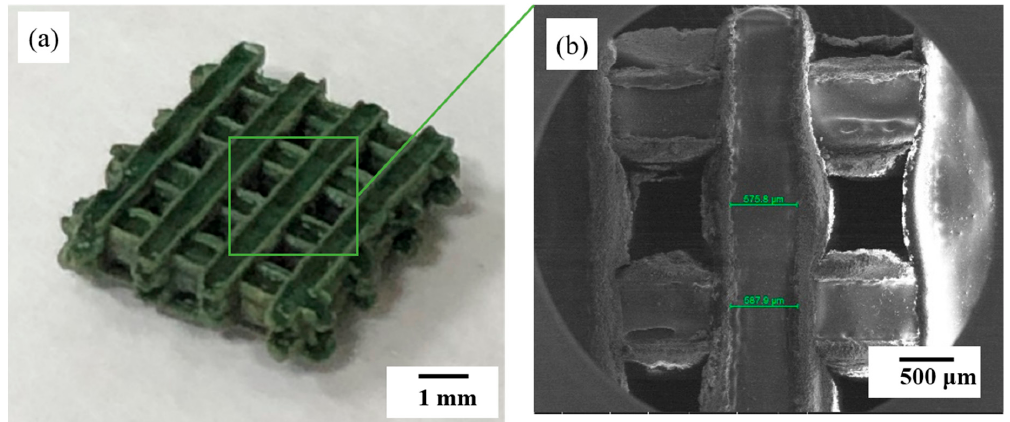
Figure 10. ( a ) Optical and ( b ) scanning electron microscope (SEM) images of a 3D scaffold manufactured by powder bed fusion (PBF).